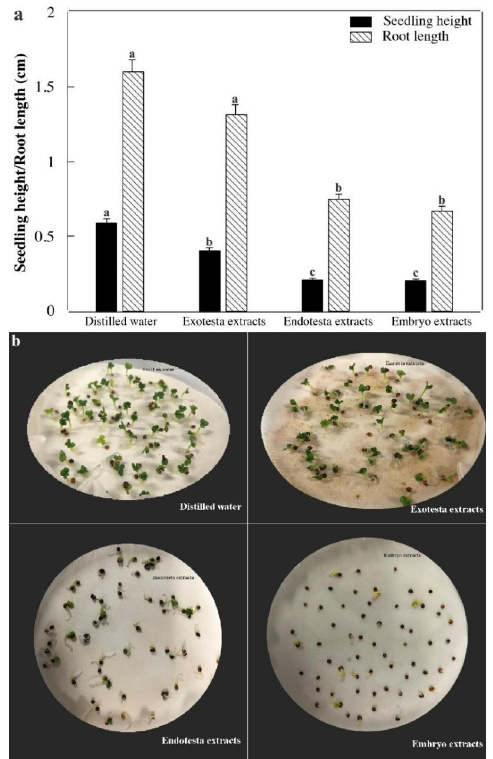
Figure 8. Seedling height and root length of cabbage seeds under different treatments. Different letters over bars indicate significant differences ( a ). Distilled water, exotesta extracts, endotesta extracts, and embryo extracts of Chinese pistache seeds were added to Petri dishes with filter papers to cultivate cabbage seeds. Growth characteristics of cabbage under different treatments after incubation for 72 h ( b ).